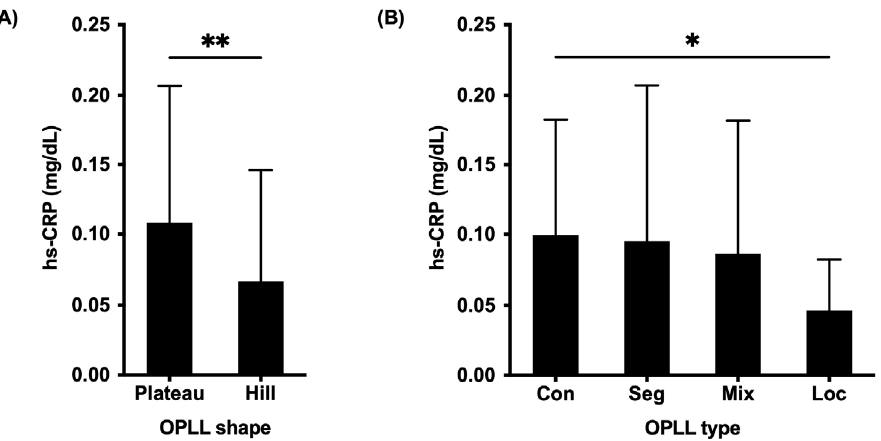
Figure 3. Comparison of serum high-sensitivity C-reactive protein levels between the OPLL types ( A ) and OPLL shapes ( B ). OPLL, ossification of the posterior longitudinal ligament; hs-CRP, high- sensitivity C-reactive protein; con, continuous; seg, segmental; mix, mixed; loc, localized; *, p < 0.05; **, p < 0.01.